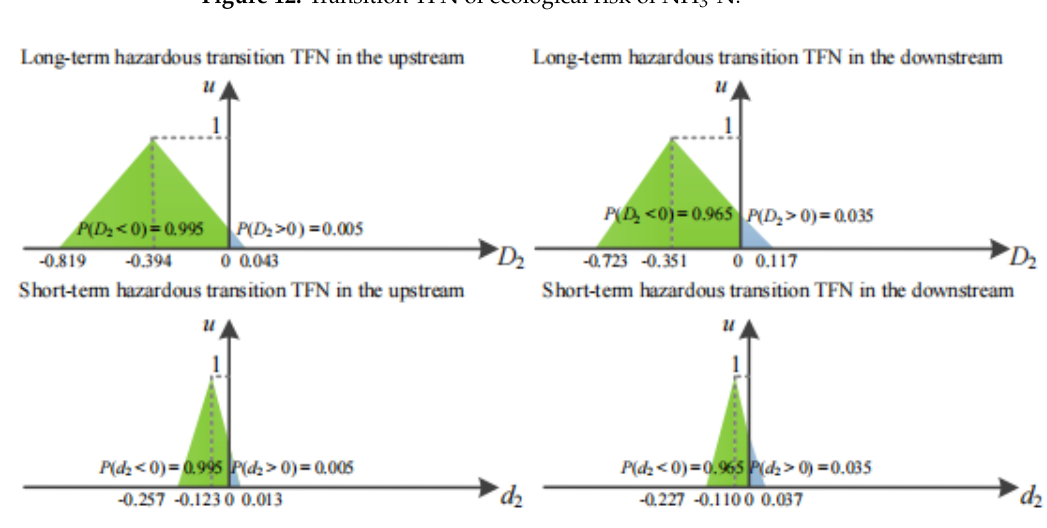
Figure 12. Transition TFN of ecological risk of NH 3 -N.